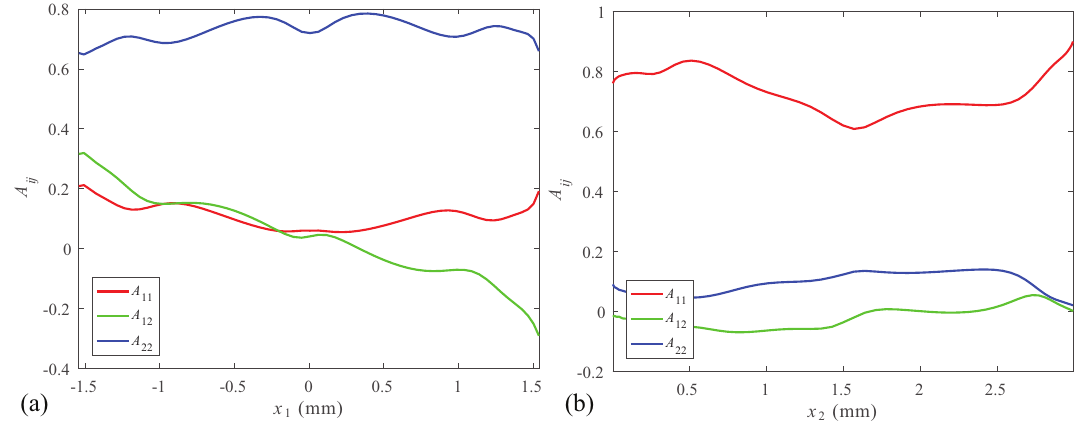
Figure 4. Orientation tensors calculated using the IRD model with C I = 10 − 2 . ( a ) A ij as a function of x 1 at the nozzle exit, calculated using the model in Figure 2, and ( b ) A ij as a function of x 2 within the deposited bead, calculated using the model in Figure